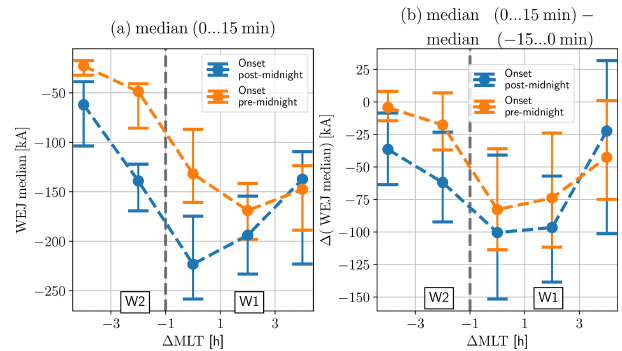
Figure 12. The median WEJ after the onset and the difference in the median WEJ between time steps before and after the onset sep- arated for pre-midnight onsets and post-midnight onsets as well as bootstrapped 90% confidence